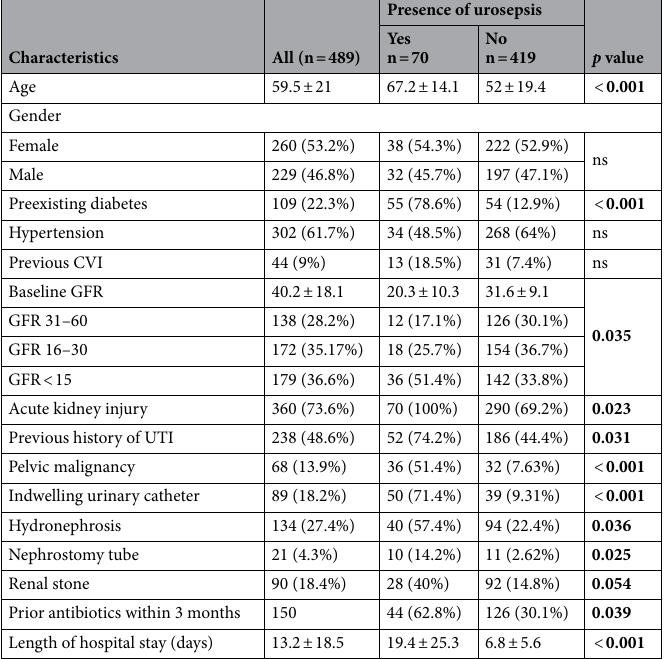
Patients with UTI n = 419